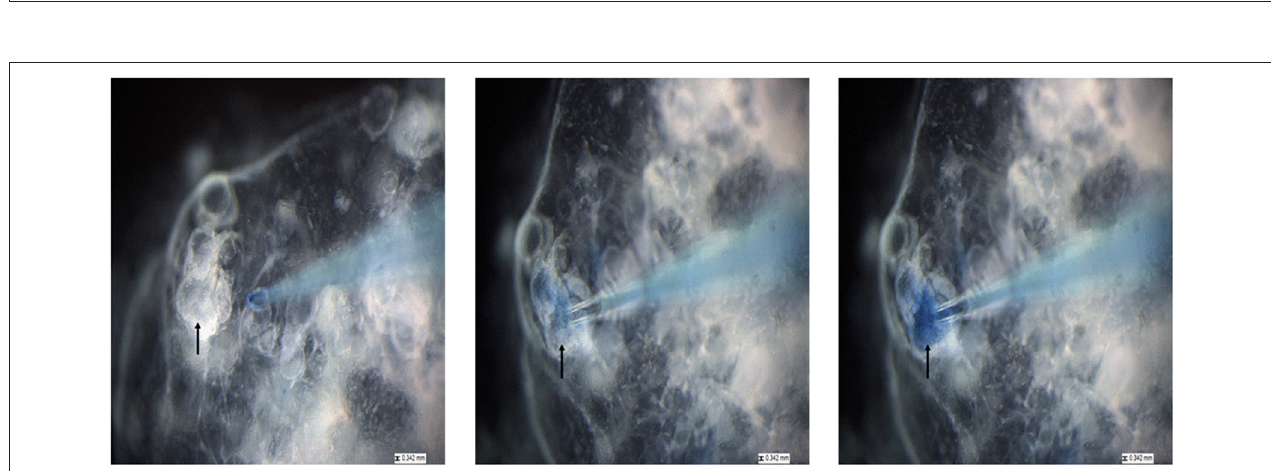
FIGURE 4 | Expression of Type 1 and Type 2 alveolar epithelial cell markers. Three independent organoids stained with both cell markers AQP5 (green) and SFTPC (red). From left to right. (A) Bright field images of organoids. (B) Stained with DAPI. (C) AQP5 5 staining. (D) SFTPC staining. (E) Merged image of all cell markers. Scale bars are 50 µ m.